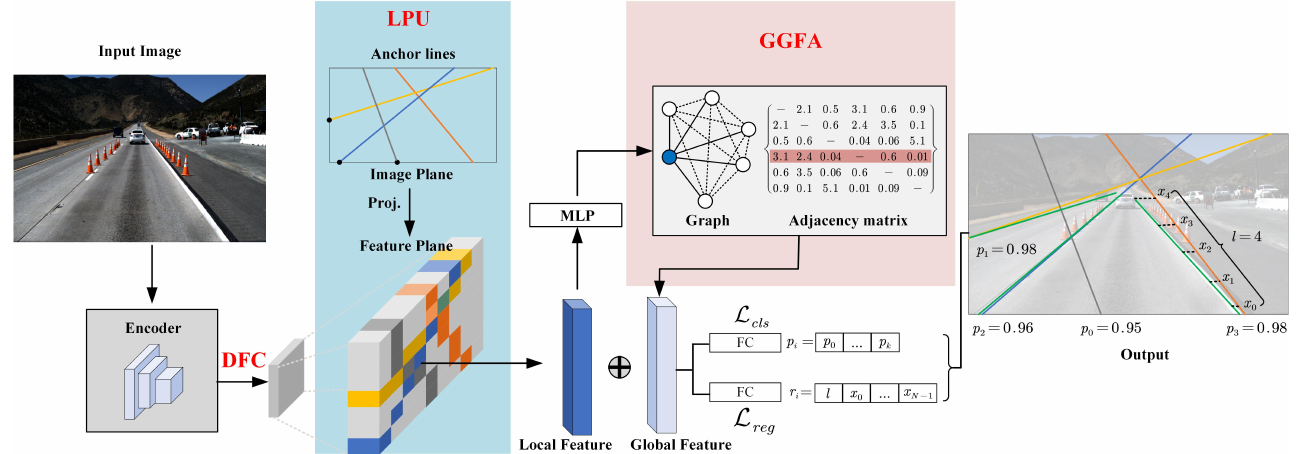
Figure 2. An overview of our method. An encoder generates high-dimensional feature maps from an input image. DFC is then applied to reduce the dimension of features. Subsequently, LPU generates a large number of predefined anchor lines. They are projected onto the feature maps, and the local features can be obtained by pixel-wise extraction. Then, with the input of the local features, GGFA aggregates the global feature with a strong perception. Finally, the concatenated features are fed into two layers (one for classification and another for regression) to make the final